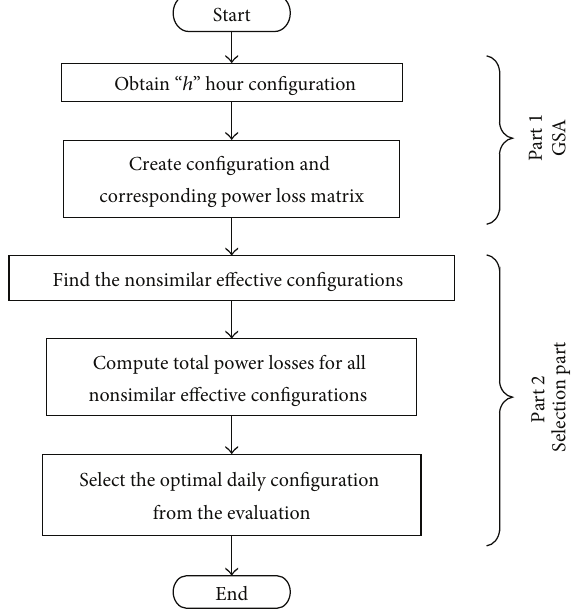
Figure 1: Flowchart of the proposed